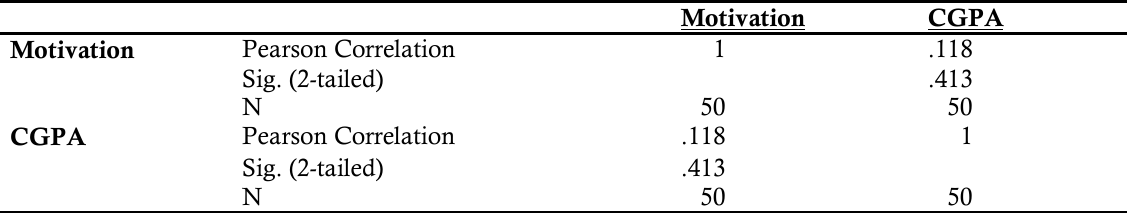
Table 1 Correlation between Motivation and Academic Performance of the graduate students